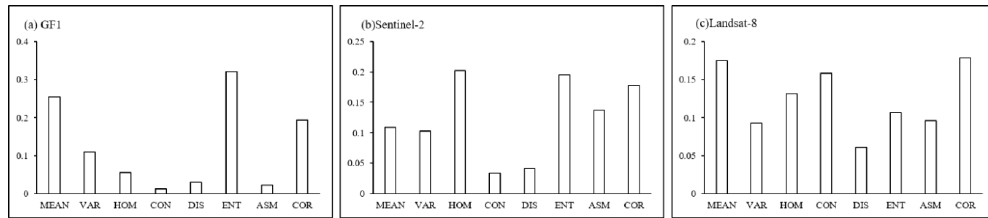
Figure 5. Feature importance of gray-level co-occurrence matrix (GLCM) textural features for GF-1 ( a ), Sentinel-2 ( b ) and Landsat 8 ( c ). Vertical axis represents the value of feature importance.